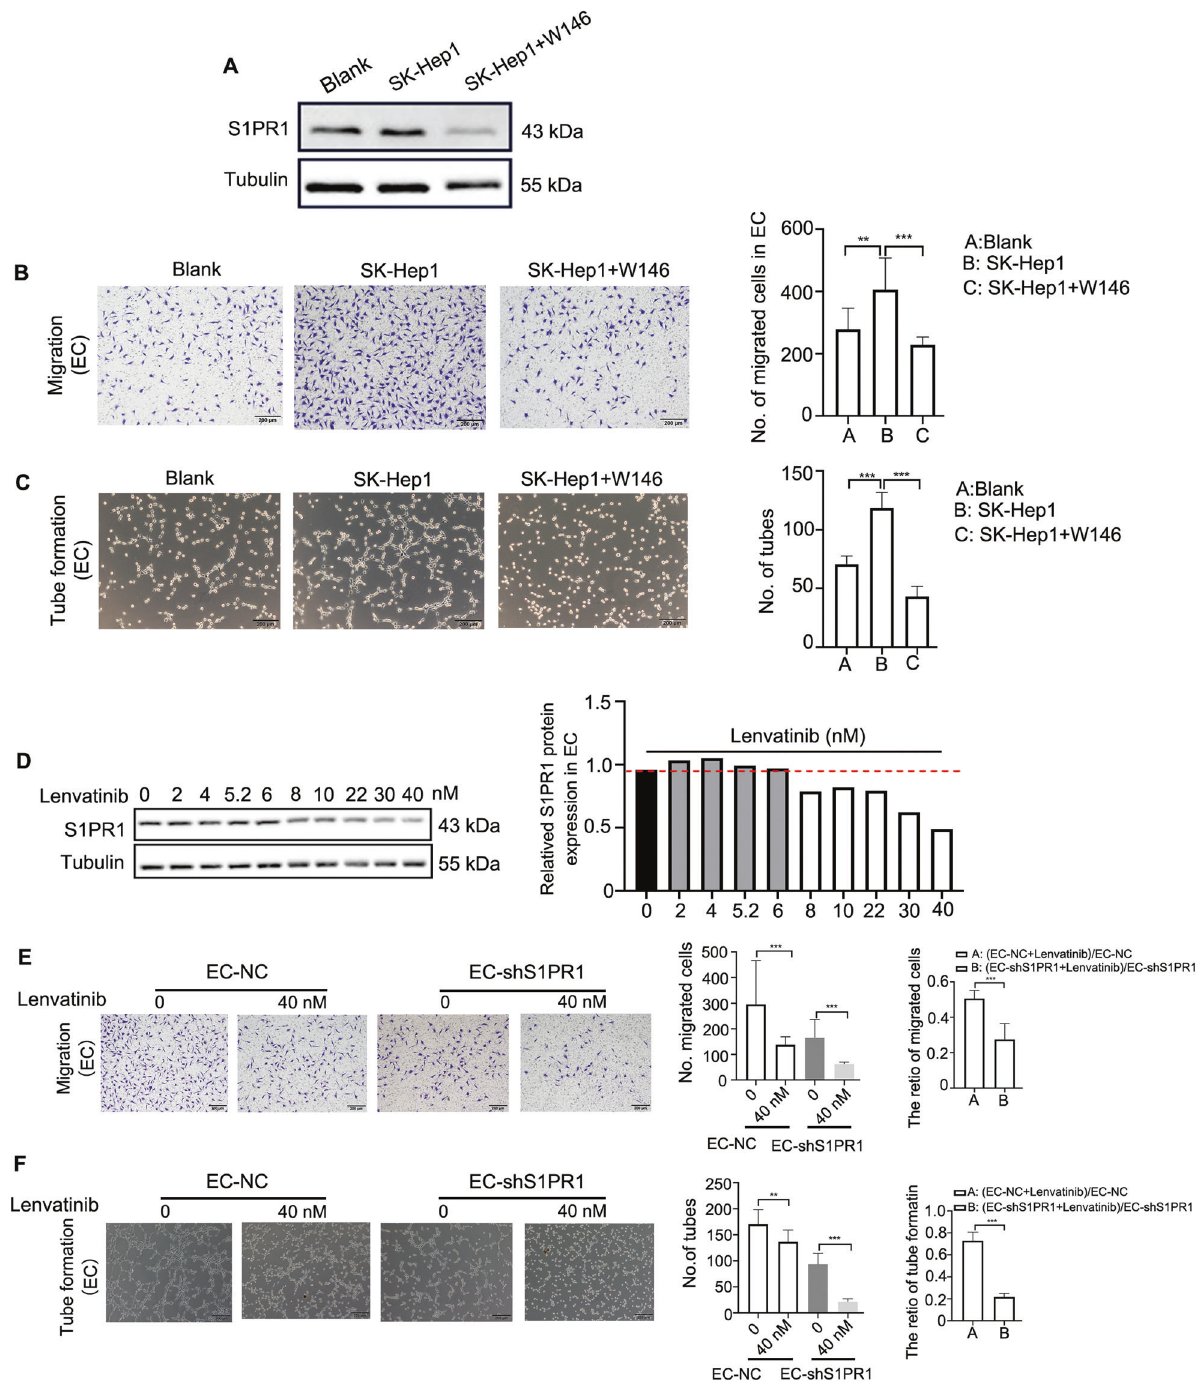
Fig. 8 W146 and Lenvatinib target S1PR1 to inhibit angiogenesis. A The inhibitory effect of W146 (20 μ M) on the promotion of S1PR1 expression induced by the media from SK-Hep1 cells was detected by WB. B , C The inhibitory effect of W146 (20 μ M) on the promotion of migration ( B ) and tube formation ( C ) of ECs induced by media from SK-Hep1 cells was detected. Scale bar: 200 μ m. D S1PR1 protein expression was tested in ECs treated with Lenvatinib at different concentrations (0 – 40 nM), and the grey value was calculated by ImageJ. E , F Migration ( E , left) and tube formation ( F , left) of EC-NC, EC-shS1PR1 and EC-shS1PR1 treated with Lenvatinib (40 nM) were tested, and the synergistic effect of Lenvatinib combined with knockdown of S1PR1 on the migration ( E , right) and tube formation ( F , left) of EC was analysed. Scale bar: 200 μ antiangiogenic drug targeting S1PR1 for HCC treatment. Lenva- effect. The results showed that W146 inhibited the expression of tinib, as a small molecule inhibitor of multiple receptor tyrosine S1PR1 in EC (Fig. 8A), and W146 also reduced the promotion of kinases, has been demonstrated to potently block angiogenesis migration and tube formation in EC induced by HCC superna owing to its ability to target multiple receptors, including VEGFR1- tant (Fig. 8B, C), indicating that W146 might be a potential